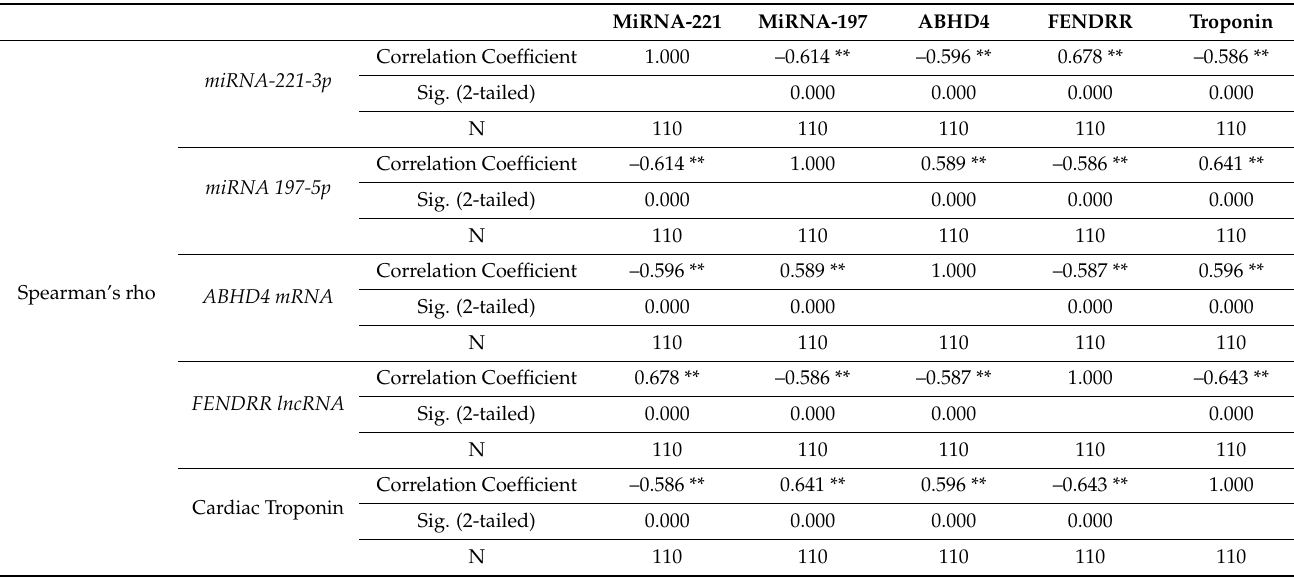
Table 3. Correlation between ABHD4 RNA panel and cardiac troponin among the study groups.